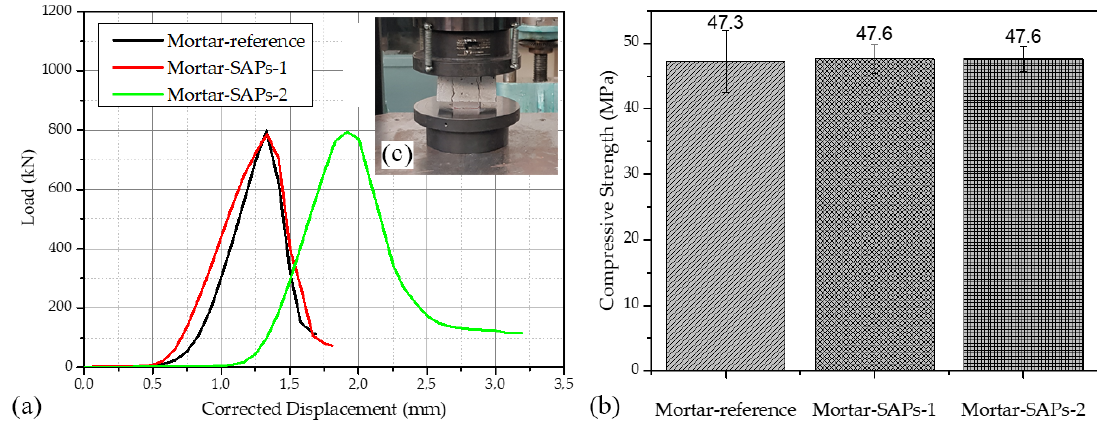
Figure 5. Maximum values of loads for mortar specimens at 28 days of age ( a ), compressive strength of mortar specimens at 28 days of age ( b ), optical image of specimen after compressive test ( c ).